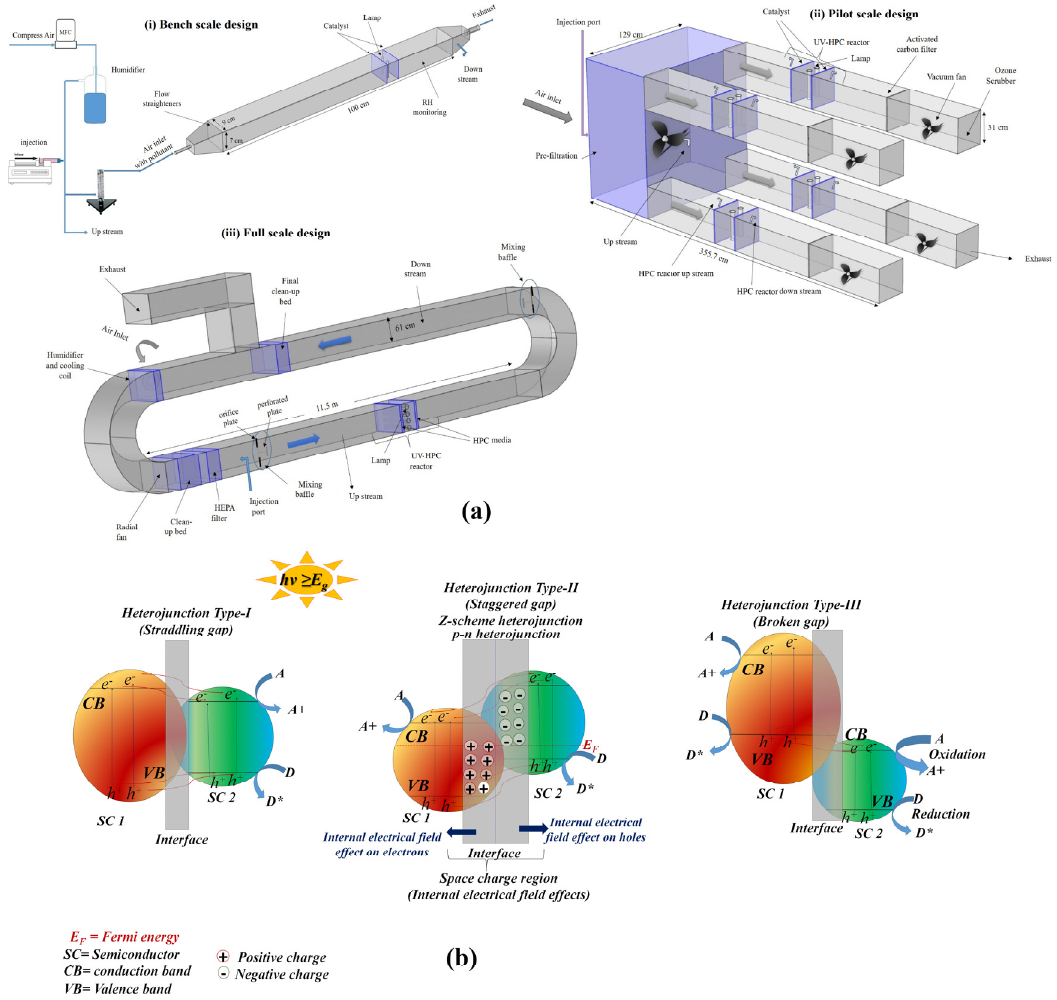
Figure 2. Schematic of ( a ) the indoor air photoreactor design (Reprinted from [21], with permission of Elsevier) and ( b ) semiconductor photocatalyst e − /h + pair separation between heterojunction surfaces.